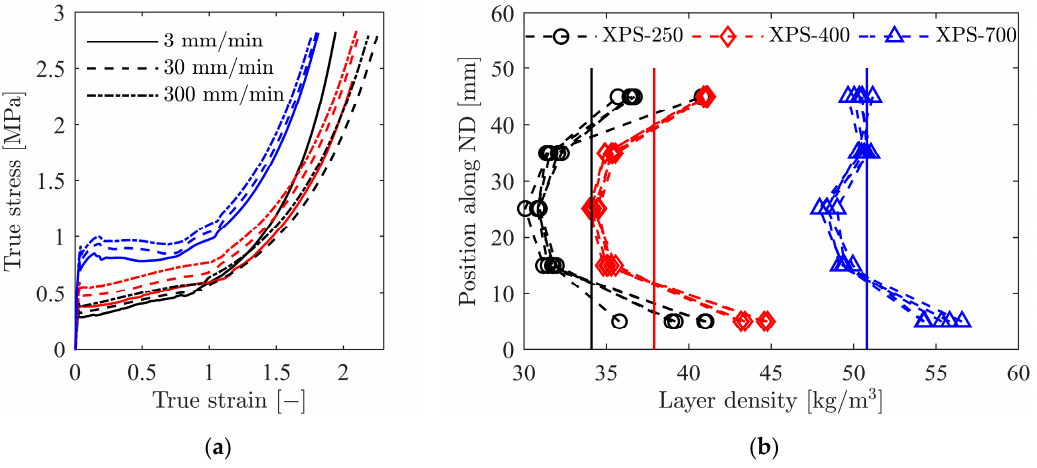
Figure 2. (a) Typical true stress-strain curves from material compression tests of extruded polystyrene (XPS) foams in the thickness direction (ND) as a function of density and strain rate, and (b) density variation through the ND direction of the XPS foams. All plots are reproduced from [6].